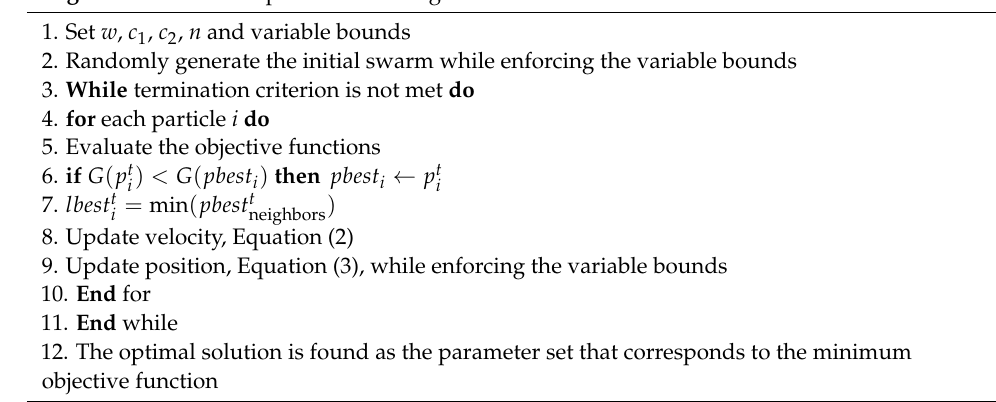
Algorithm 2. Main Steps of the PSO